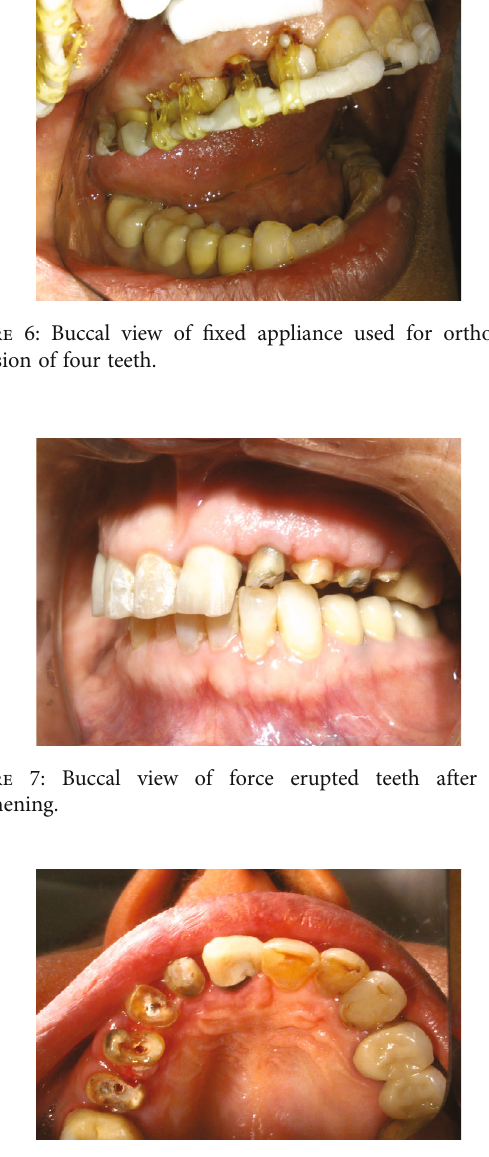
Figure 8: Occlusal view of force erupted teeth after crown